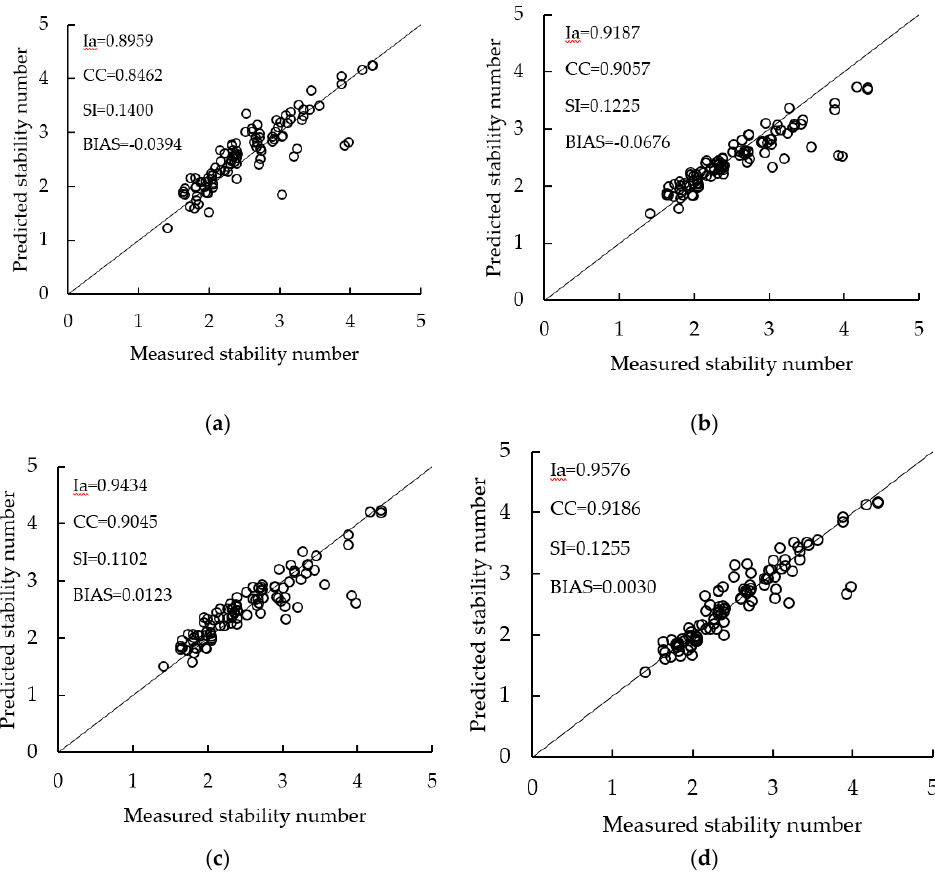
Figure 6. A performance comparison of different methods: ( a ) the van der Meer formula; ( b ) Etemad-Bonakdar formula; ( c ) GPM1 formula; and ( d ) M2 model. Table 3. The evaluation indices of the performance of di ff erent models (2 ≤ S ≤ 8).